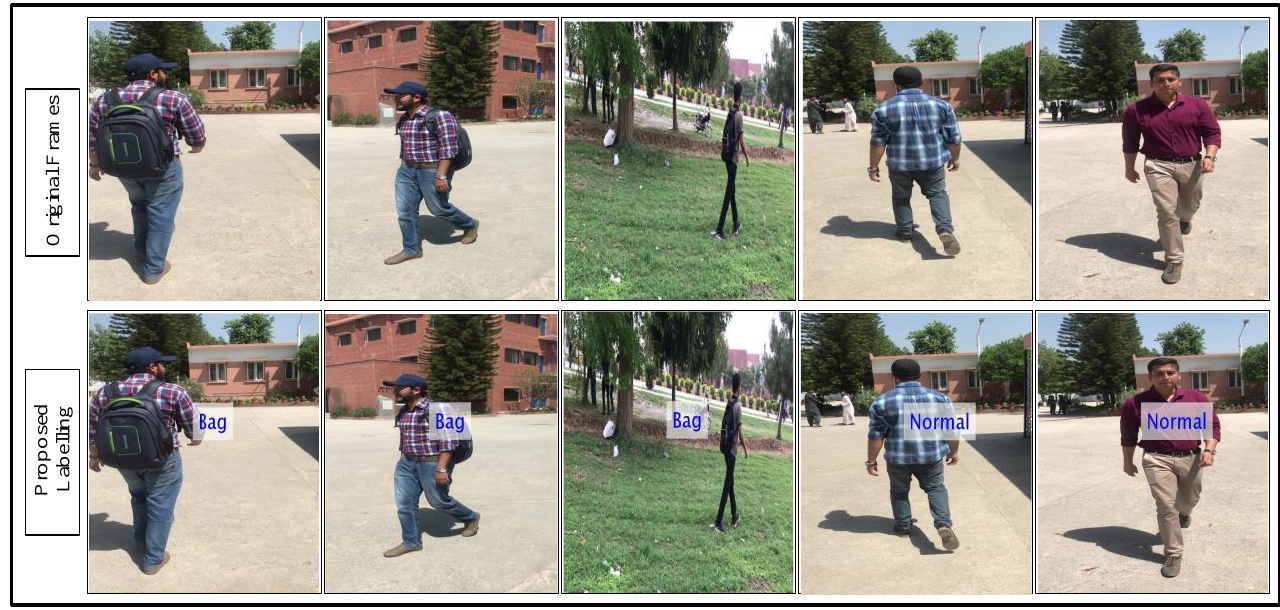
Figure 5. Proposed system predicted labeling results.